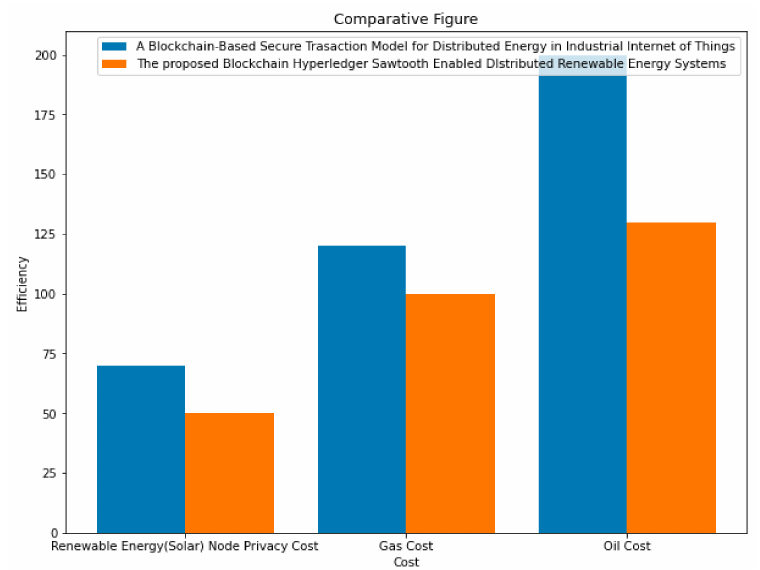
Figure 13. Comparison of the proposed EPS-Ledger with other State-of-the-Art Methods